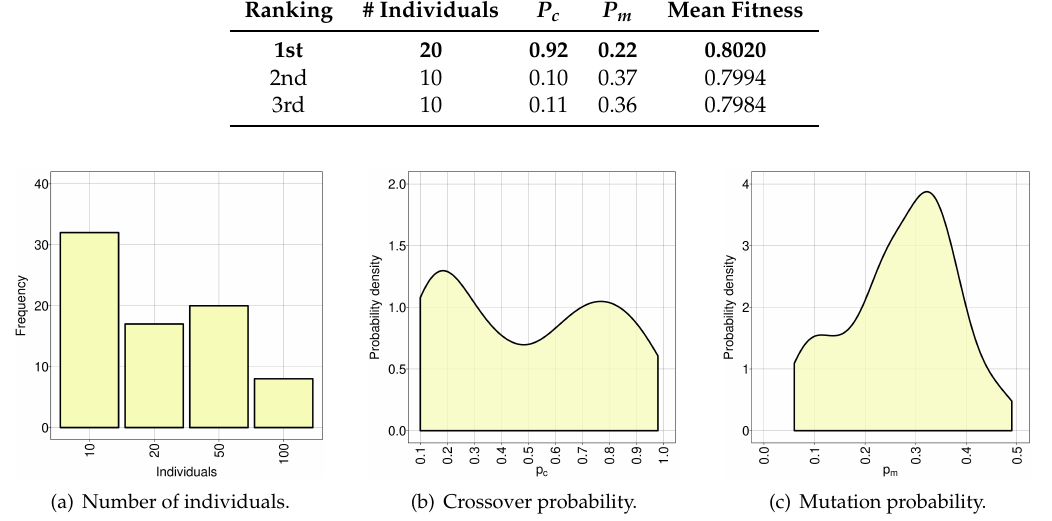
Figure 7. Frequency of the tests performed during the irace run for: the number of individuals ( a ); crossover probability ( b ); and mutation probability ( c